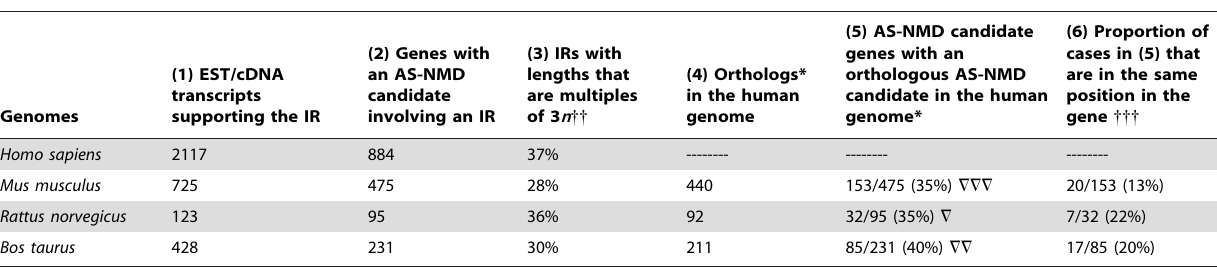
Table 2. Summary of the AS-NMD candidates involving intron retentions (IRs).